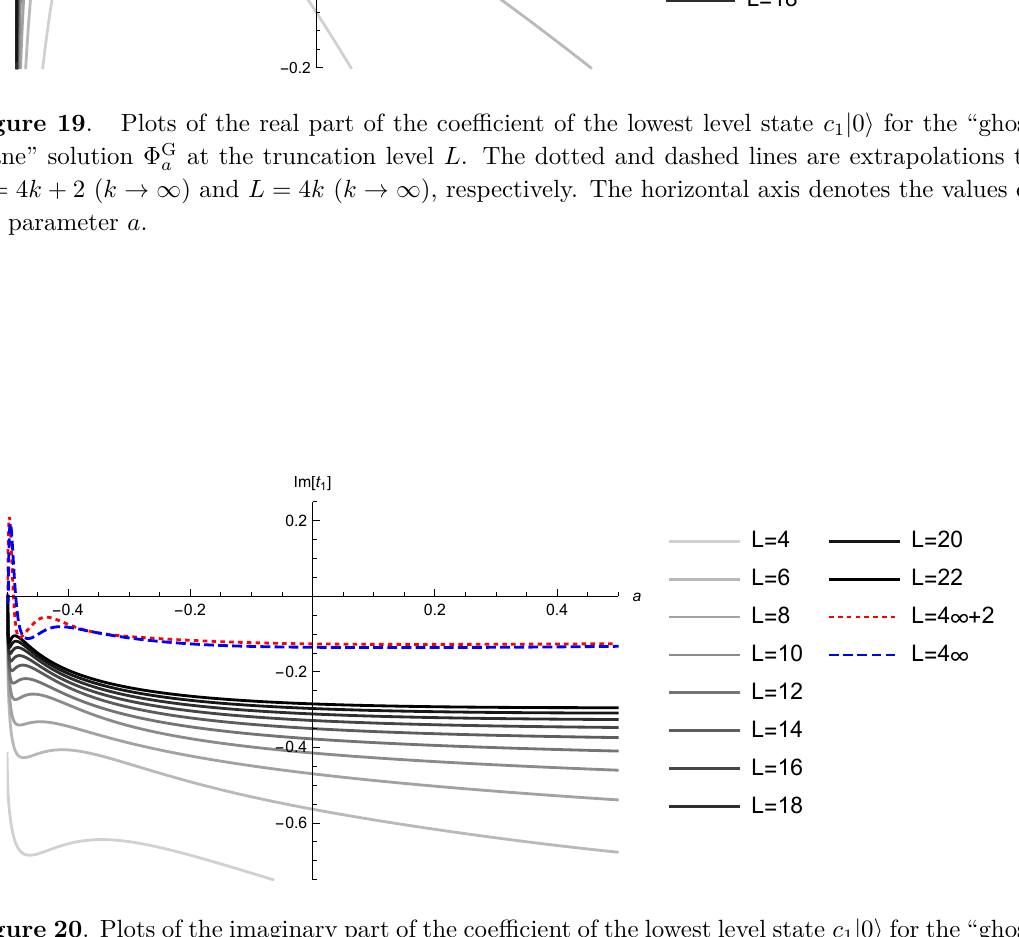
Figure 20 . Plots of the imaginary part of the coefficient of the lowest level state c 1 | 0 i for the “ghost brane” solution Φ G at the truncation level L . The dotted and dashed lines are extrapolations to a L = 4 k + 2 ( k → ∞ ) and L = 4 k ( k → ∞ ), respectively. The horizontal axis denotes the values of the parameter a